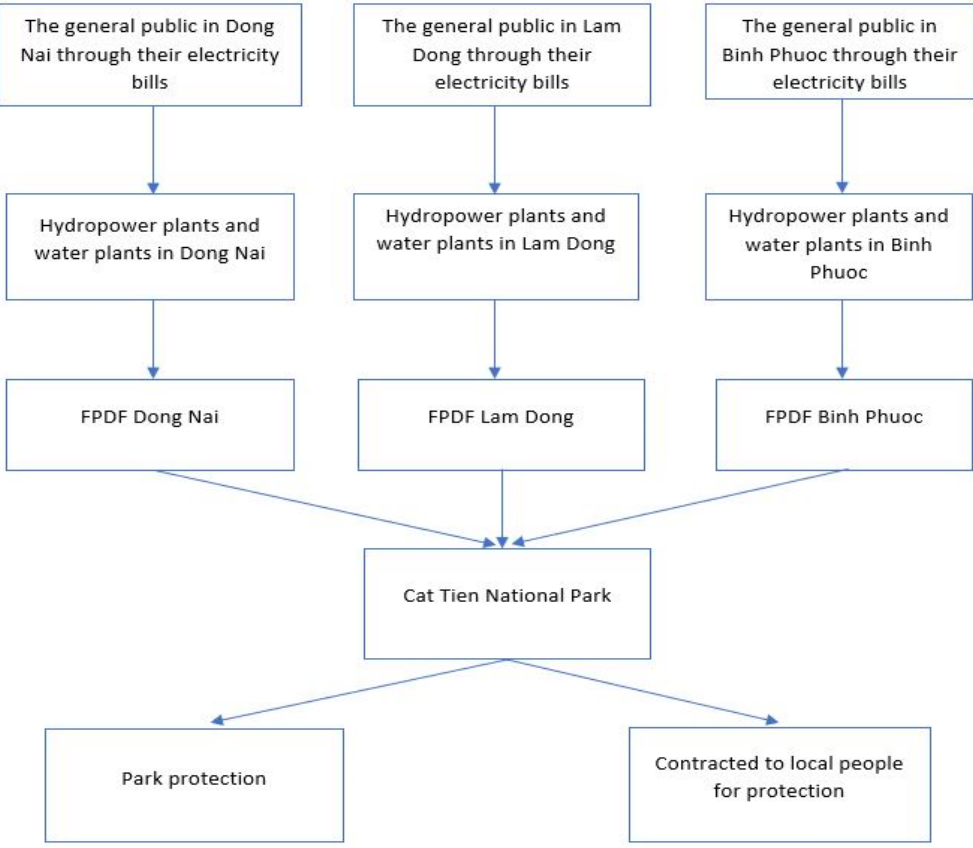
Figure 2. PFES financial flows in Cat Tien National Park. Source: compiled by the research team.